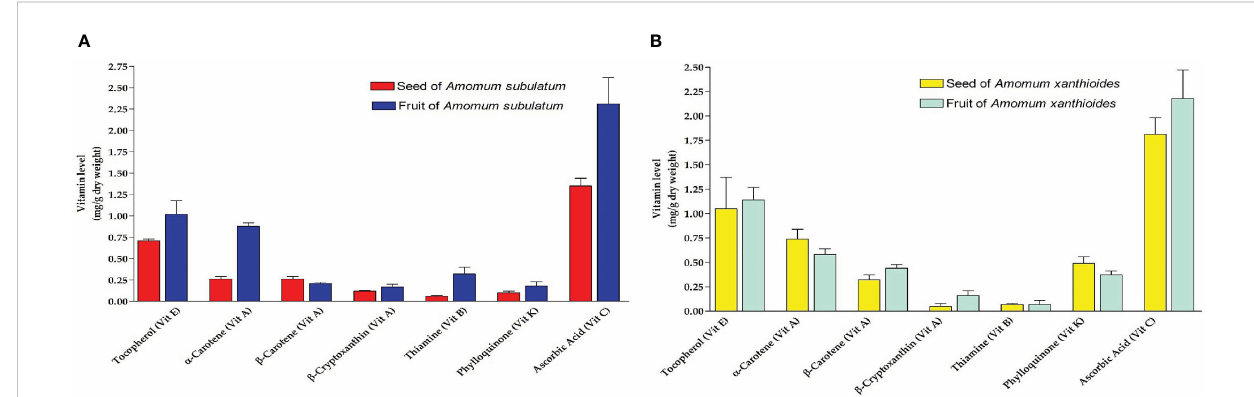
FIGURE 4 Vitamins levels (mg/g dry weight) isolated in (A) seed and fruit of Amomum subulatum and (B) seed and fruit of Amomum xanthioides . The data are shown as the mean ± SEM of four plants per group. a p < 0.05 versus seeds of A . subulatum , c p < 0.05 versus fruits of A . subulatum